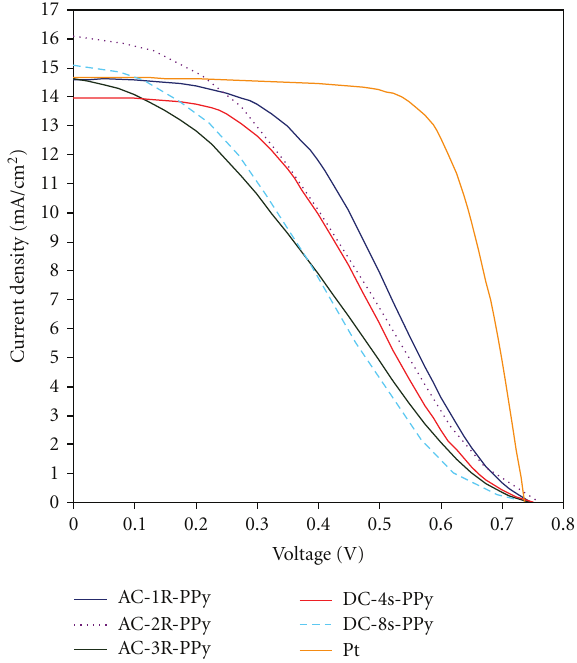
Figure 5: Photocurrent density ( J ) versus. photovoltage ( V ) curves of PPy and Pt DSSCs.